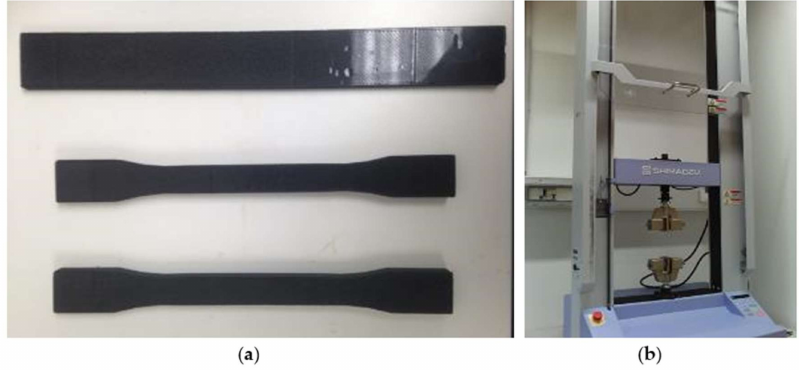
Figure 5. Test specimens ( a ) tensile (“dog bone”, lower) and shear (rectangular, upper) and ( b ) SHIMAZU tensile machine.